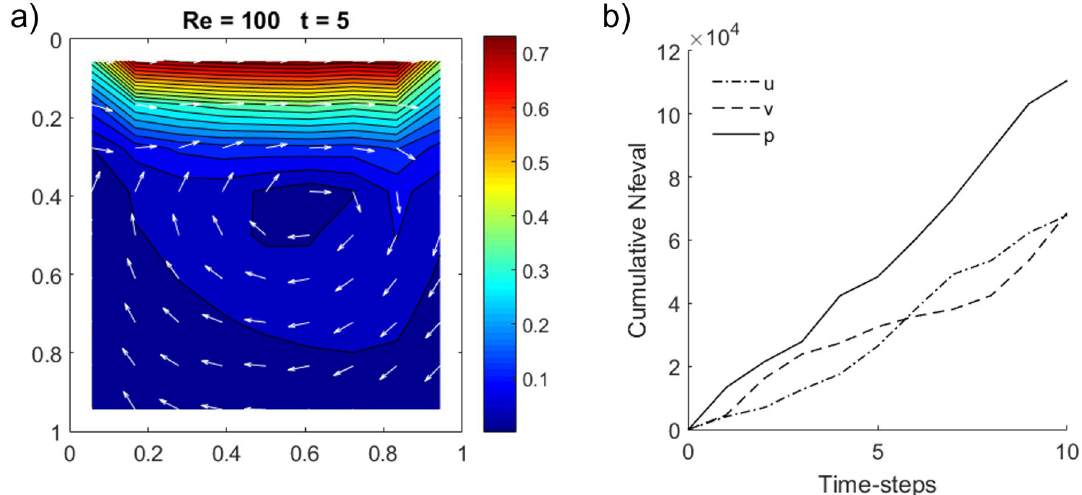
100 ) on a 2 n 8 8 grid at (cid:31) t 0.5 up to T 5 and upper = = × = = 1 . Color map indicates velocity magnitude with normalized =